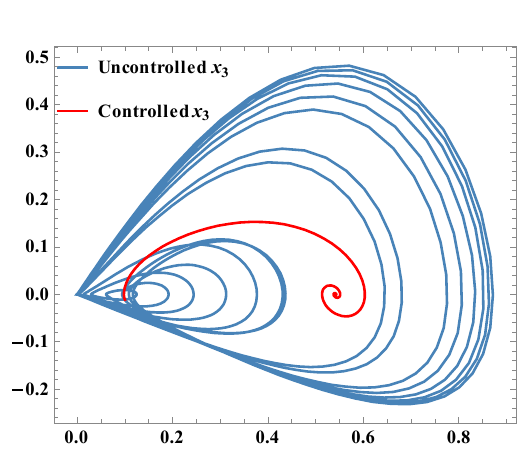
Figure 6. Phase plots of x 3 .